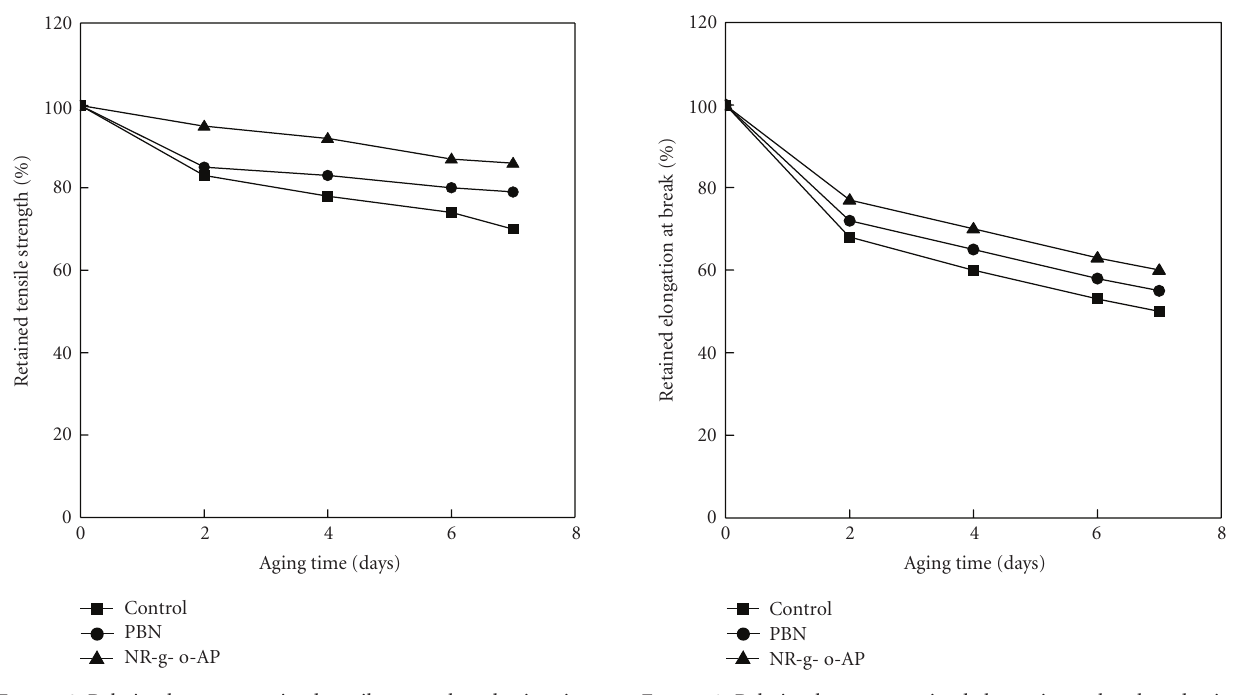
Figure 8: Relation between retained tensile strength and aging time for NBR vulcanizates containing PBN, NR-graft- o -AP, and control vulcanizate.